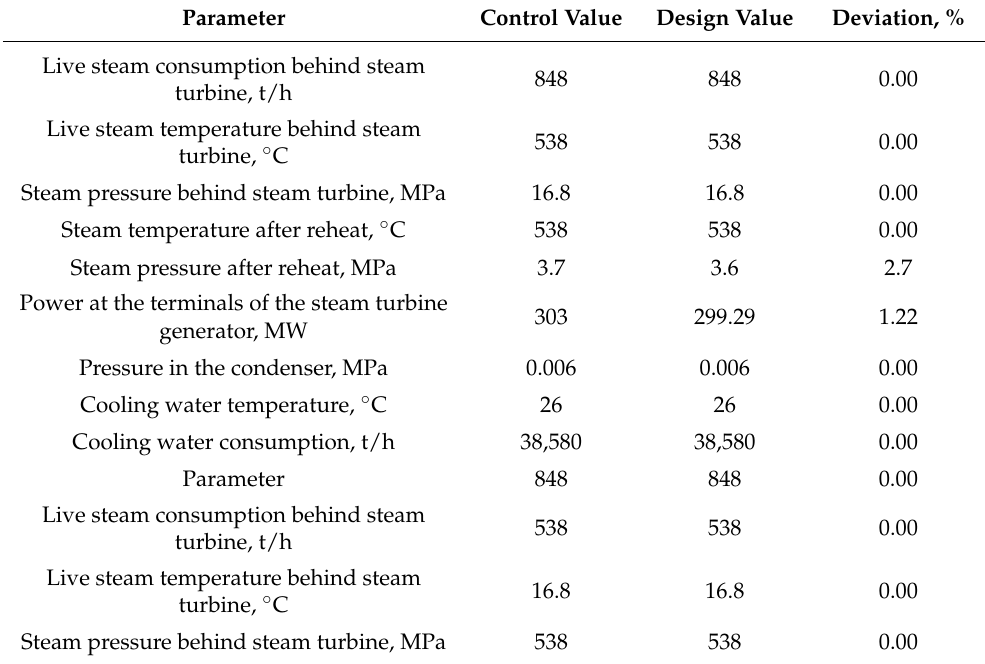
Table 1. Control and design value comparison of the K-300-170-1P turbine unit operation.